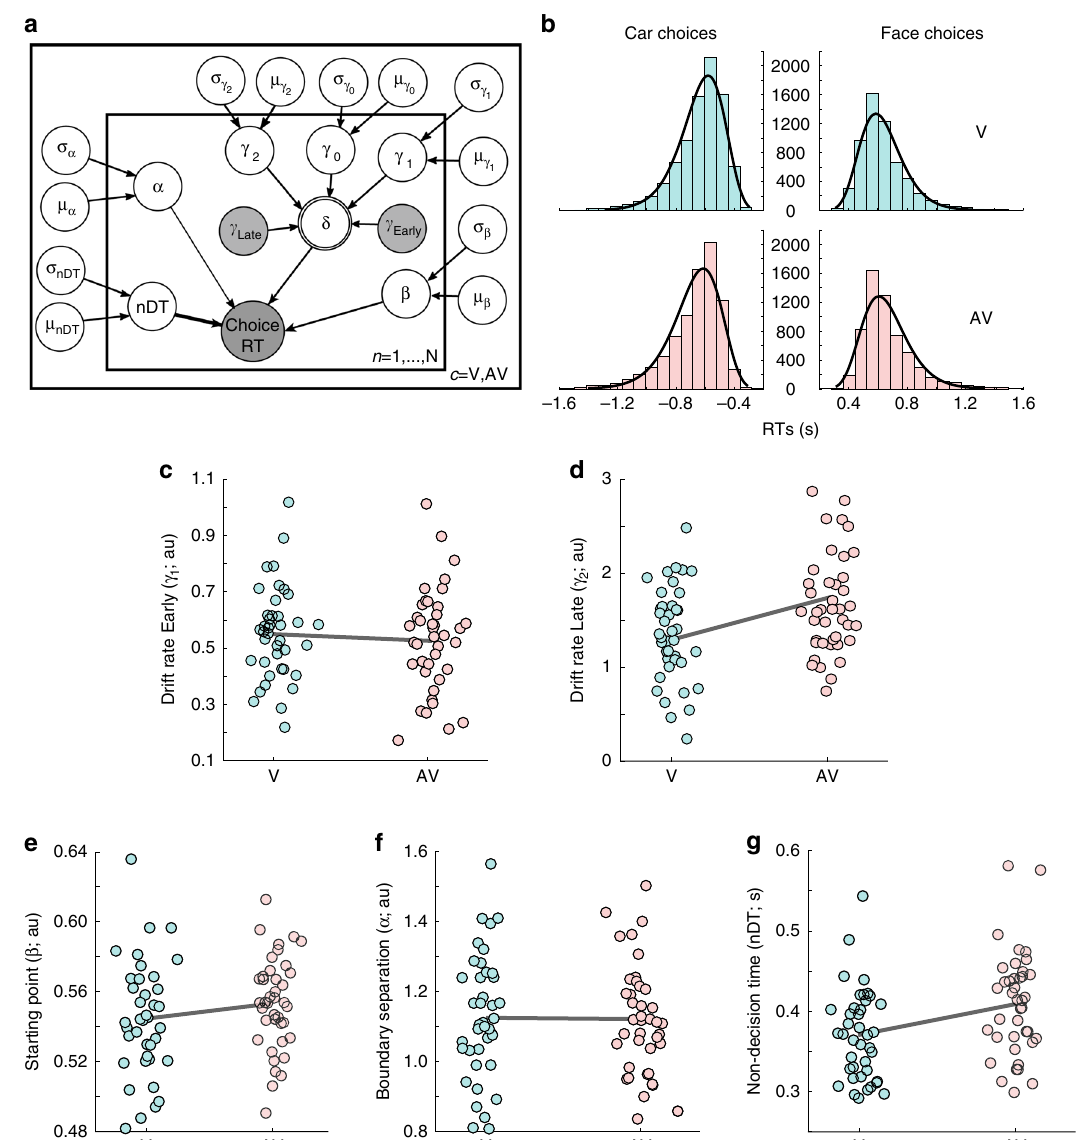
Fig. 5 Neurally informed cognitive modelling. a Graphical representation showing hierarchical estimation of nHDDM parameters. Round nodes represent continuous random variables and double-bordered nodes represent deterministic variables, de fi ned in terms of other variables. Shaded nodes represent recorded or computed signals, i.e., single-trial behavioral data (choice, RT) and EEG component amplitudes ( y ’ s). Parameters are modeled as random variables with inferred means μ and variances σ 2 . Plates denote that multiple random variables share the same parents and children. The outer plate is over sensory conditions (V, AV) and the inner plate is over participants ( n ). b Histogram and nHDDM model fi ts for RT distributions of car (left) and face (right) choices in the visual (V; top — in turquoise) and audiovisual (AV; bottom — in red) conditions. c , d Regression coef fi cients ( γ ) of the c Early and d Late EEG component amplitudes ( y ’ s) in V (turquoise) and AV (red) conditions, as predictors of the drift rate ( δ ) of the nHDDM shown in a . Coef fi cients derived from nHDDM, including n = 40 independent participants and 28,540 trials. e Starting point values ( β ) estimated by the nHDDM for V (turquoise) and AV (red) conditions. f Boundary separation values ( α ) estimated by the nHDDM for V (turquoise) and AV (red) conditions. g Nondecision times (nDT) estimated by the nHDDM for V (turquoise) and AV (red) conditions. Dots indicate single-participant values and gray lines connect the population means in c – g . Source data for this fi gure are provided as a Source data fi often than faces (60 ± 8% of the V trials and 52 ± 8% of the AV we observe a starting point bias closer to face choices (expressed as trials were car choices), and are more accurate (84% vs 74% on a proportion of the boundary separation, two-sided paired t tests: average) in trials with a face choice. This accuracy effect is com- t (39) = 9.06 for V and t (39) = 10.63 for AV, both p values < 0.001) parable across V and AV trials (two-sided paired t test: t (39) = and a higher drift rate for car choices, in both the V and AV − 0.98, p = 0.3353; 83.2 ± 1.34% for V and 86.59 ± 1.14% for AV conditions ( δ car-V = − 0.92 ± 0.14, δ face-V = 0.15 ± 0.13, δ car-AV = = 0.07 ± 0.12 — positive (negative) signs − 0.96 ± 0.14, δ face choices, 72.84 ± 0.98% for V and 76.9 ± 0.91% for AV car face-AV indicate face (car) choices). To understand these results, we choices). examined potential differences in the behavioral results between These results suggest that the bias in the starting point is likely face and car choices. In particular, participants choose cars more driving the accuracy difference between face and car choices (i.e.,